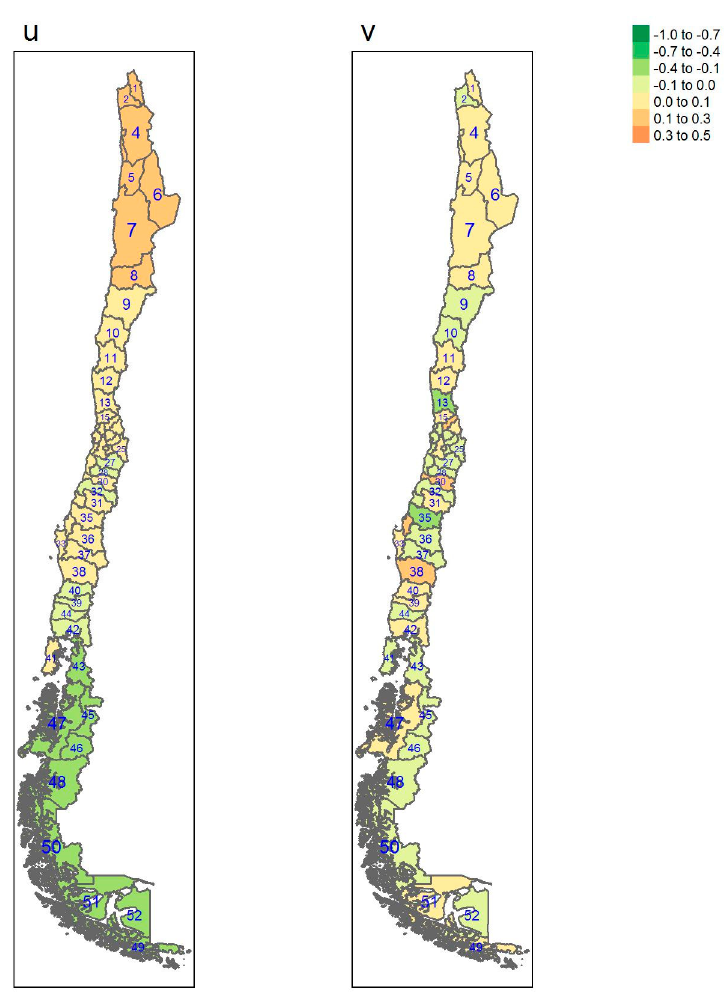
Figure1. Multi-scalemodelheterogeneitye ff ectsfordiabetes(u: correlatede ff ect; v: uncorrelatede ff Figure 1. Multi-scale model heterogeneity effects for diabetes (u: correlated effect; v: uncorrelated effect).